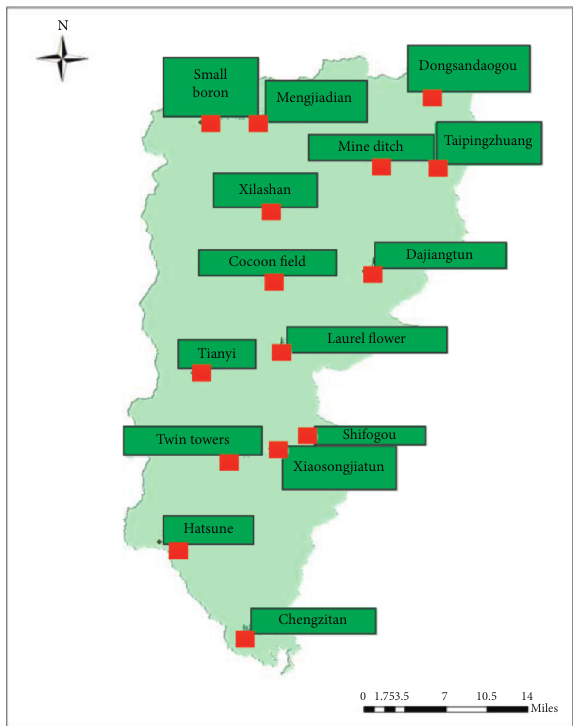
Figure 2: Survey station map of the Biliu River